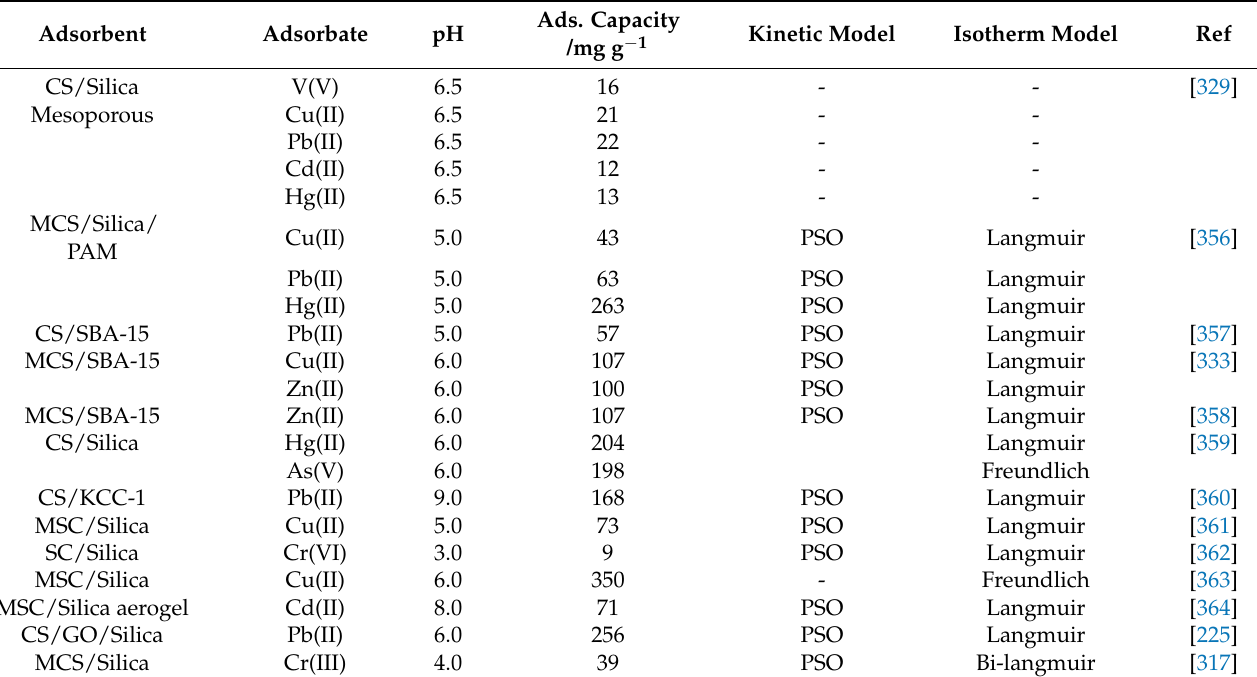
Table 7. Adsorption performance of CS/silica composites in the removal heavy metal ions from water.